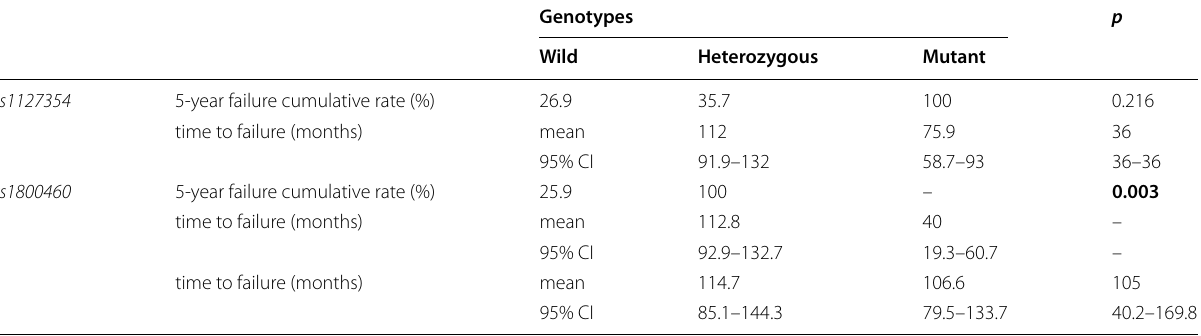
CI confidence interval Bold values indicate significant results <